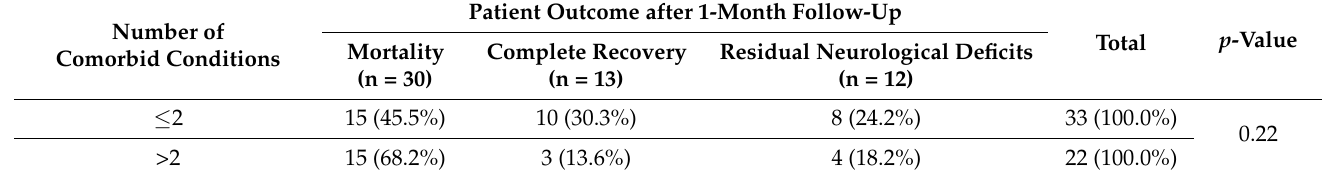
Association between subjects having co-morbidities and mortality, recovery, and neurological